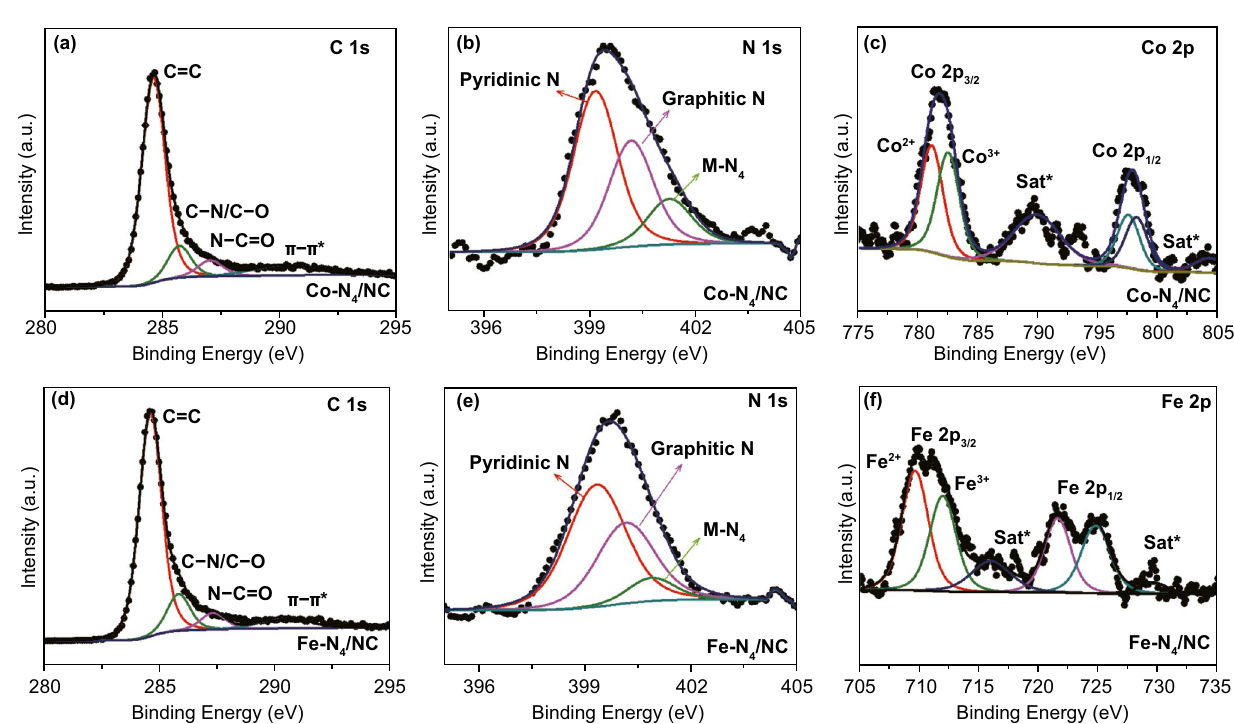
Fig. 3 XPS narrow scan of a C 1s, b N 1s, and c Co 2p for Co-N 4 /NC. XPS narrow scan of d C 1s, e N 1s, and f Fe 2p for Fe-N 4